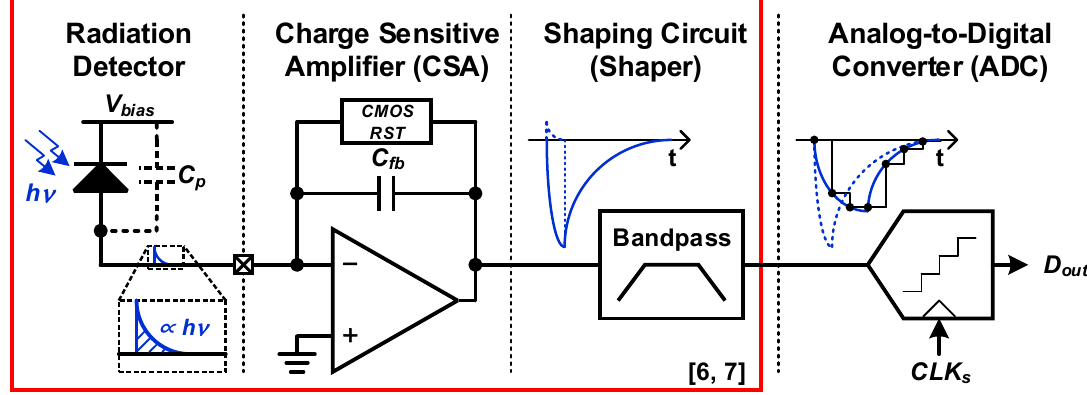
Figure 2. Architecture and operation of prior radiation sensor interfaces.